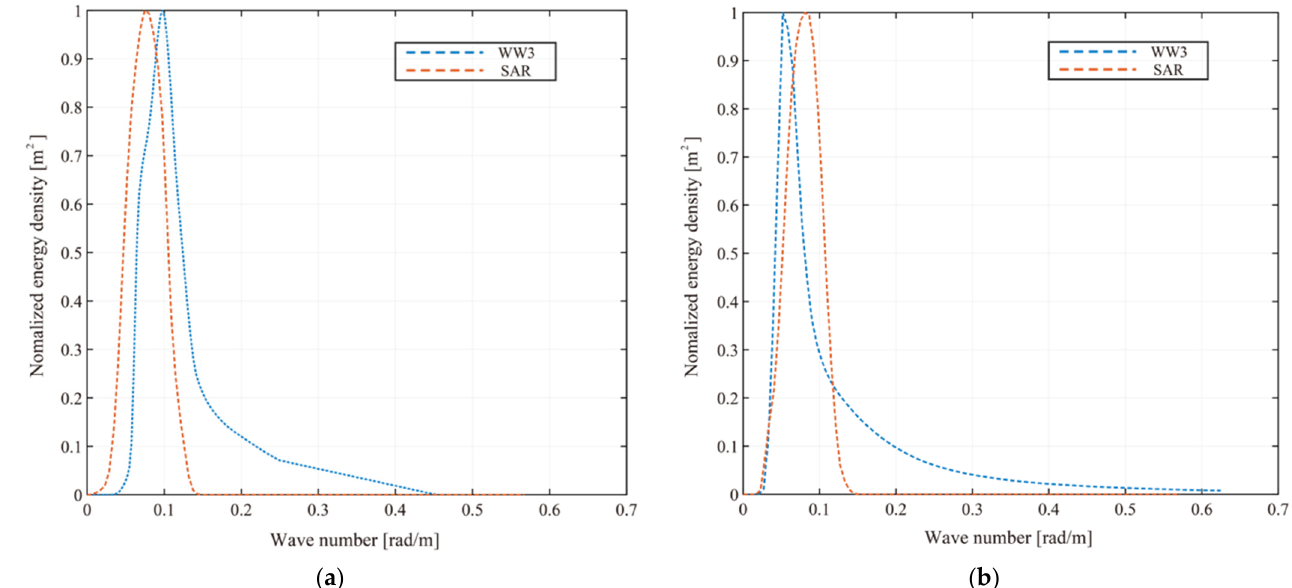
Figure 8. The one-dimensional wave spectra obtained using the parameterized first-guess spectrum method (PFSM) scheme: ( a ) results for a sub-scene of the GF-3 SAR image covering a buoyed area (ID: 46054); and ( b ) results for a sub-scene on the TS-X image covering a buoyed area (ID: 51001).